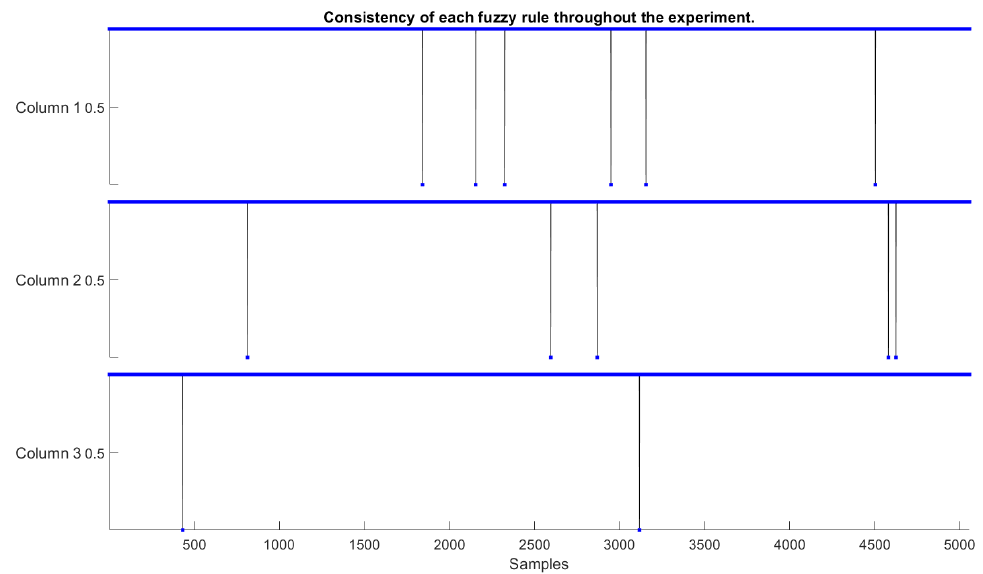
Figure 11. Consistency of fuzzy